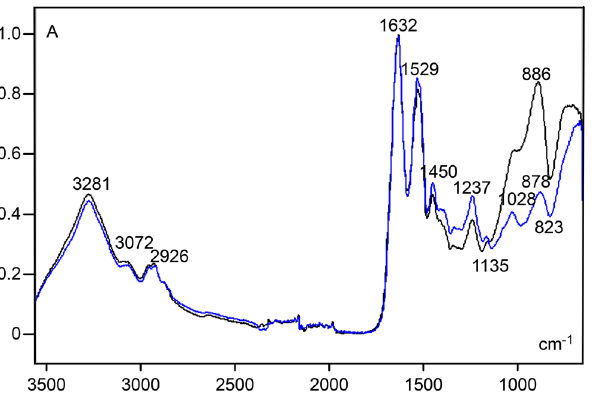
Fig 5. FT-IR spectral profiles for untreated (black line) and hyaluronidase-treated (blue line) ear cartilage ECM. The profiles were normalized with respect to the amide I peak. A, absorbances.